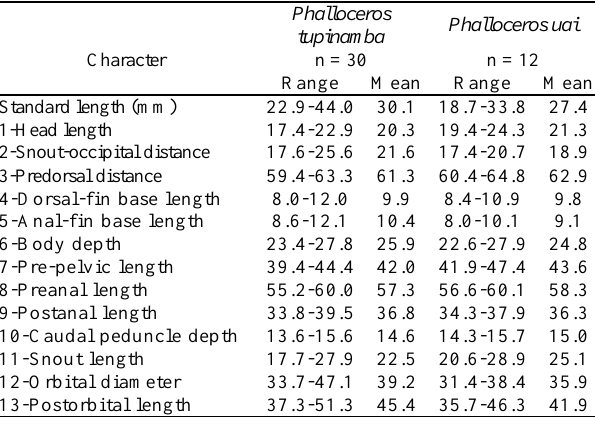
Table 7. Descriptive morphometrics of female specimens of Phalloceros tupinamba and P . uai . Measurements 1-10 are percents of standard length and measurements 11-13 are per- cents of head length.